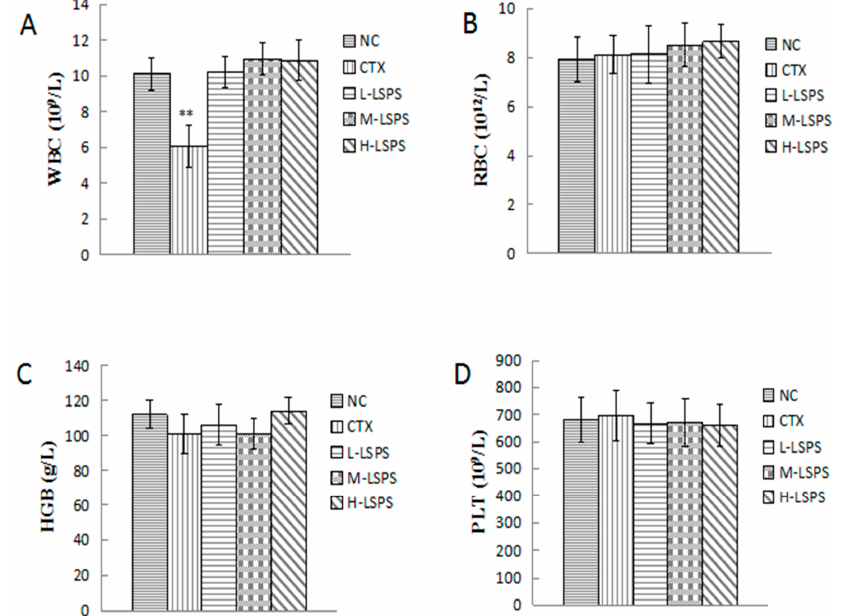
Figure 5. Effects of LSPS on WBC ( A ); RBC ( B ); HGB ( C ) and PLT ( D ) in H22 tumor-bearing mice. The